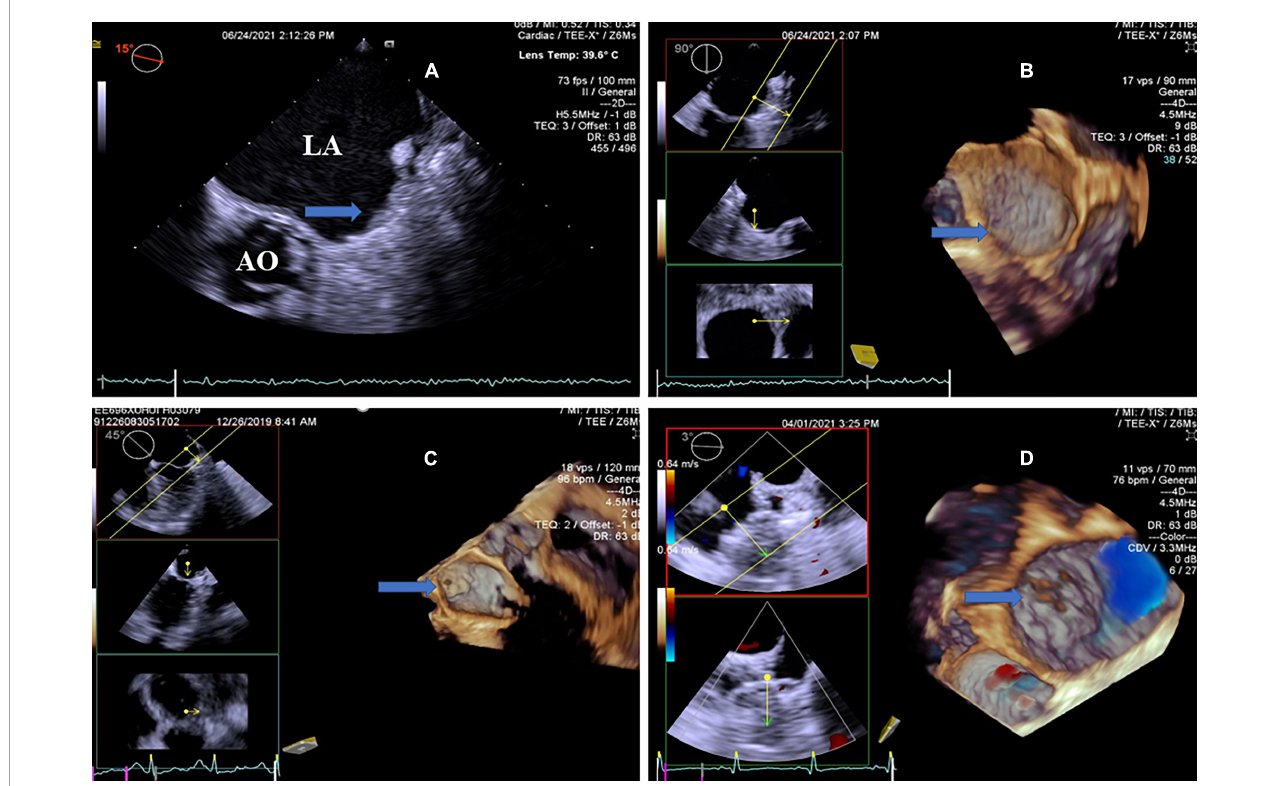
FIGURE2 Transesophageal echocardiography follow-up images after LAAC showing optimal device placement and device-related thrombus. (A) 2D-TEE showed an echo-dense mass attached to the LACbes device, occupying most area of the occluder (arrow). Note severe spontaneous echo contrast throughout the left atrium. (B) RT4D-TEE demonstrated a thin layer of thrombi covering the whole surface of the well-seated LACbes device (arrow) after LAAC, as compared with 2D-TEE. (C) RT4D-TEE indicated complete LAA closure with the Watchman device, meanwhile demonstrating a mobile thrombus pedunculated with a neck attached to the occluder (arrow). (D) RT4D-TEE detected optimal device placement and a couple of scattered clots on the surface of the Watchman occluder (arrow). There was no residual peri-device leak at the LAA ostium detected by color Doppler. RT4D-TEE: